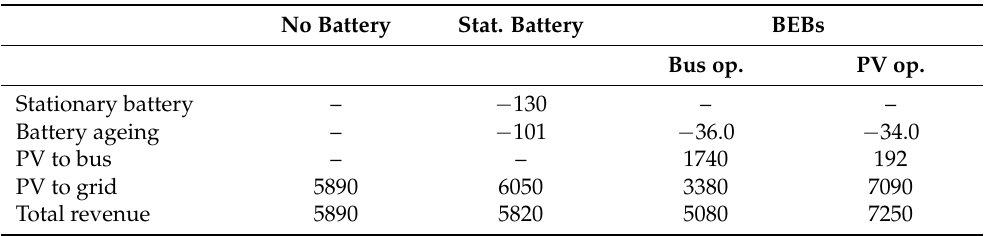
Table 5. Revenue comparison for the PV operator considering no storage, stationary batteries (1% of the installed PV capacity i.e., 13.5kWh), and BEBs (in SGD) for a ramp rate limit of 5% for one week. No Battery Stat. Battery BEBs Bus op. PV op.